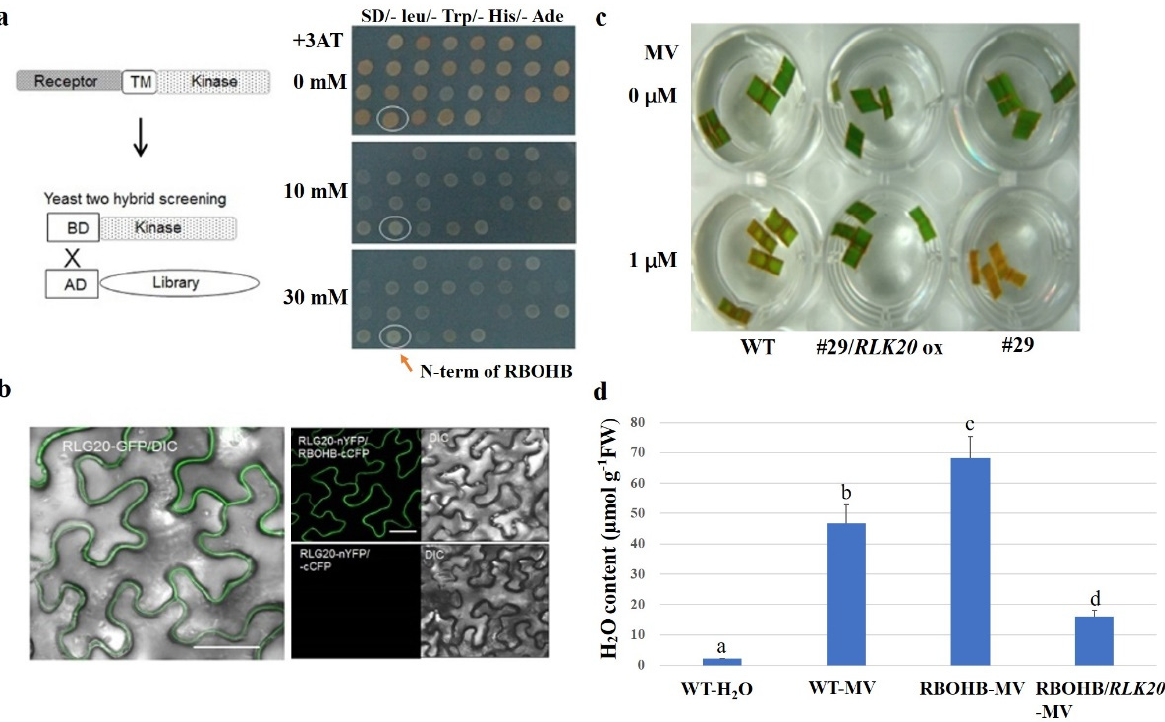
Figure 4. RLK20 interact with RBOHB regulating ROS production. ( a ) Screening of RLK20 interacting protein by the yeast two-hybrid system. ( b ) Colocalization of RLK20 and RBOBH in tobacco leaves by BiFC. ( c ) The leaves of the #29 mutant, #29/ RLK20 ox, and wild-type plants after MV treatment. ( d ) H 2 O 2 content in RBOHB -transformed or RBOHB/RLK20 -transformed tobacco leaves after being treated with MV. Data indicates the average ± standard error (SE) ( n > 6). The letters a, b, c, and d denote significant differences. p < 0.05.